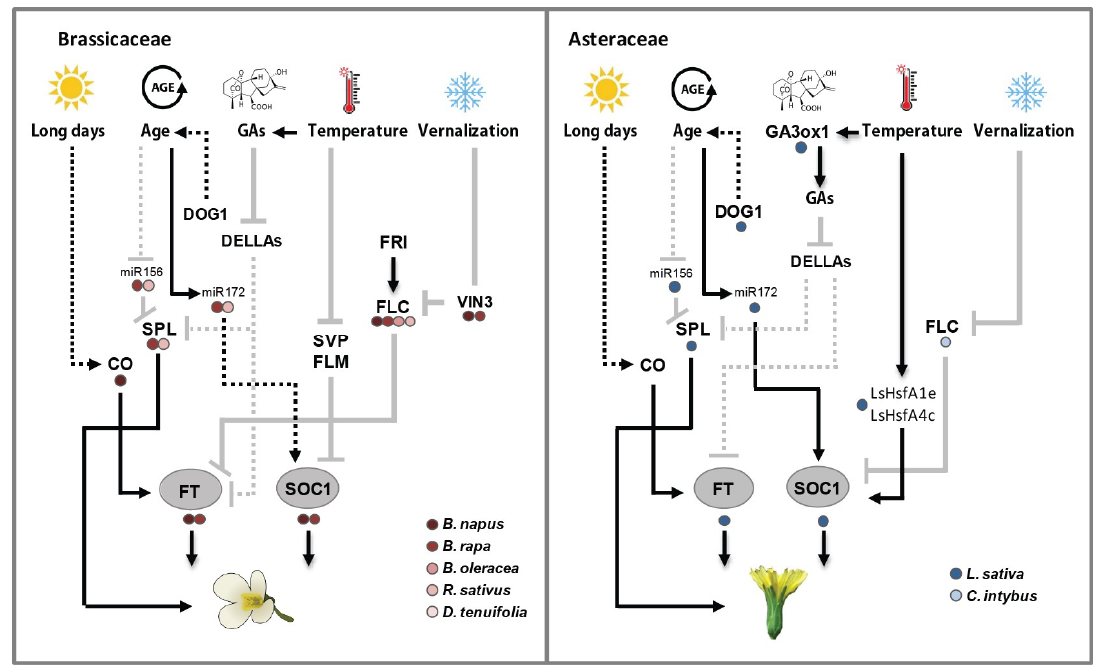
Figure 5. Simplified model of the main regulatory genes and flowering pathways acting in various crops within the Brassicaceae and Asteraceae family. Grey and black lines represent repression and induction, respectively, dotted lines indicate indirect regulation.